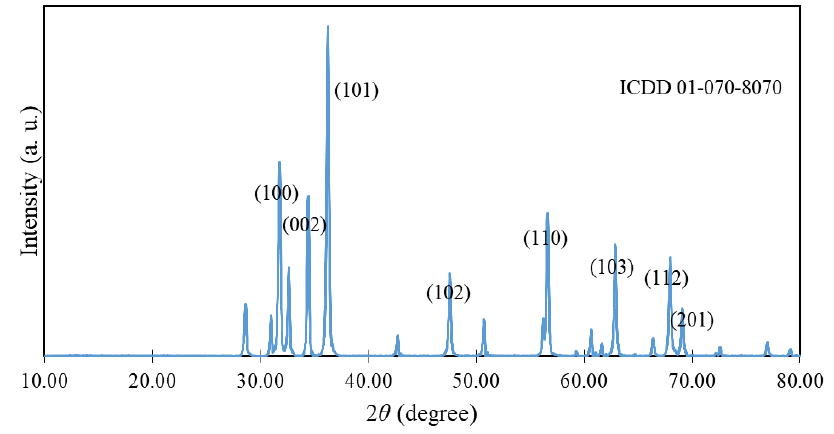
Figure 2. XRD analysis of ZnO NPs.